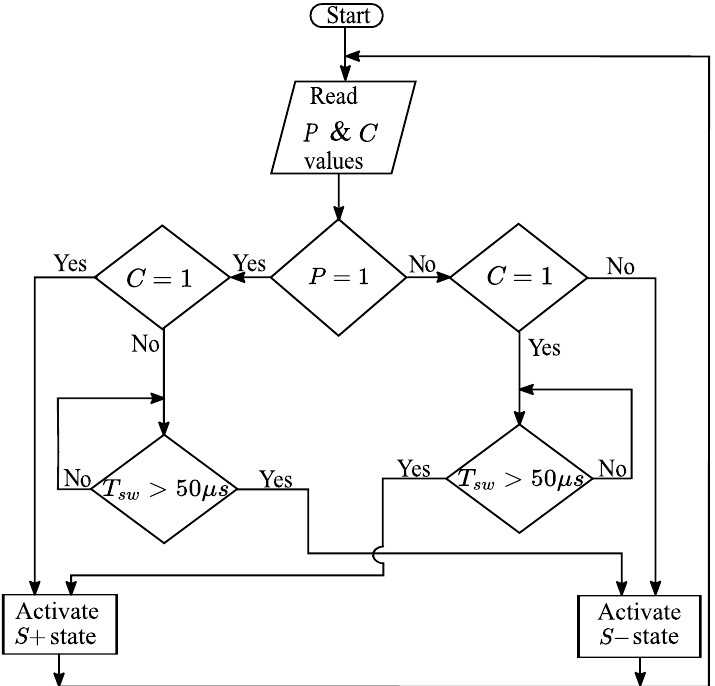
Figure 4. Flowchart of the proposed logic implemented in CPLD.